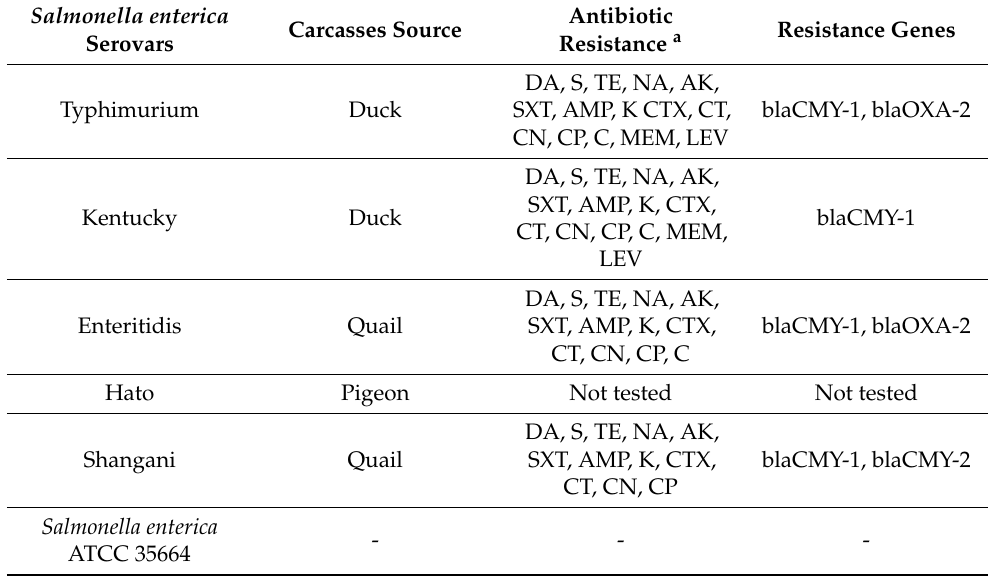
Table 1. List of Salmonella enterica serovars used in the current study. Except for the reference strain, all Salmonella serovars were previously isolated, identified, and previously tested for antibiotic sensitivity